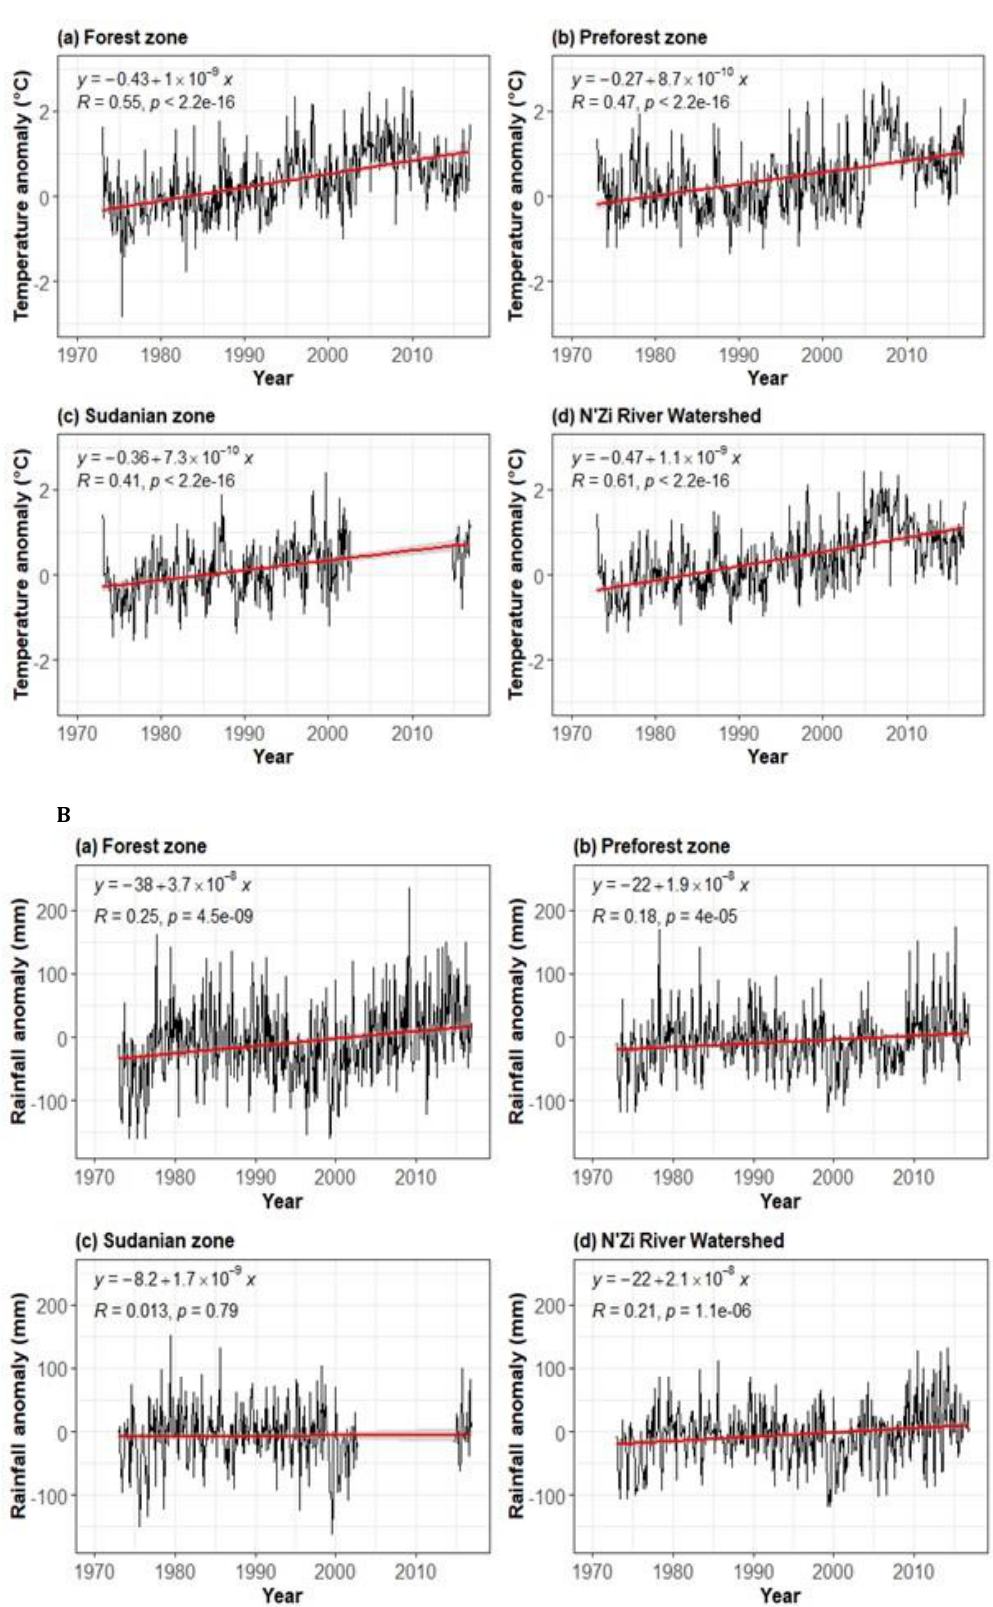
Fig. 3. Monthly temperature (A) and rainfall (B) anomalies over the three ecoregions of the N’Zi River Watershed. Anomalies are the departures from the 1980–1990 standard averaging